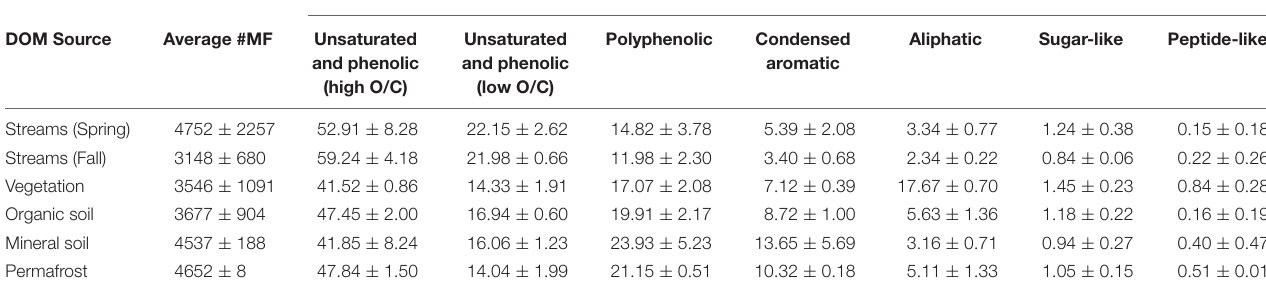
TABLE 3 | Background chemical composition of each DOM source, reflecting the percent of molecular formulae assigned to each compound class (i.e., relative abundance). Relative abundance (% of molecular formulas assigned)